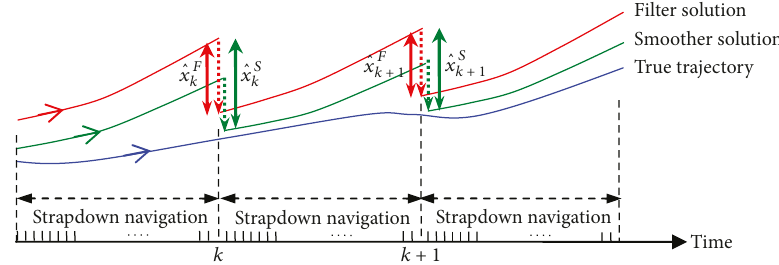
Figure 3: The data fl aw of UPS used in airborne distributed